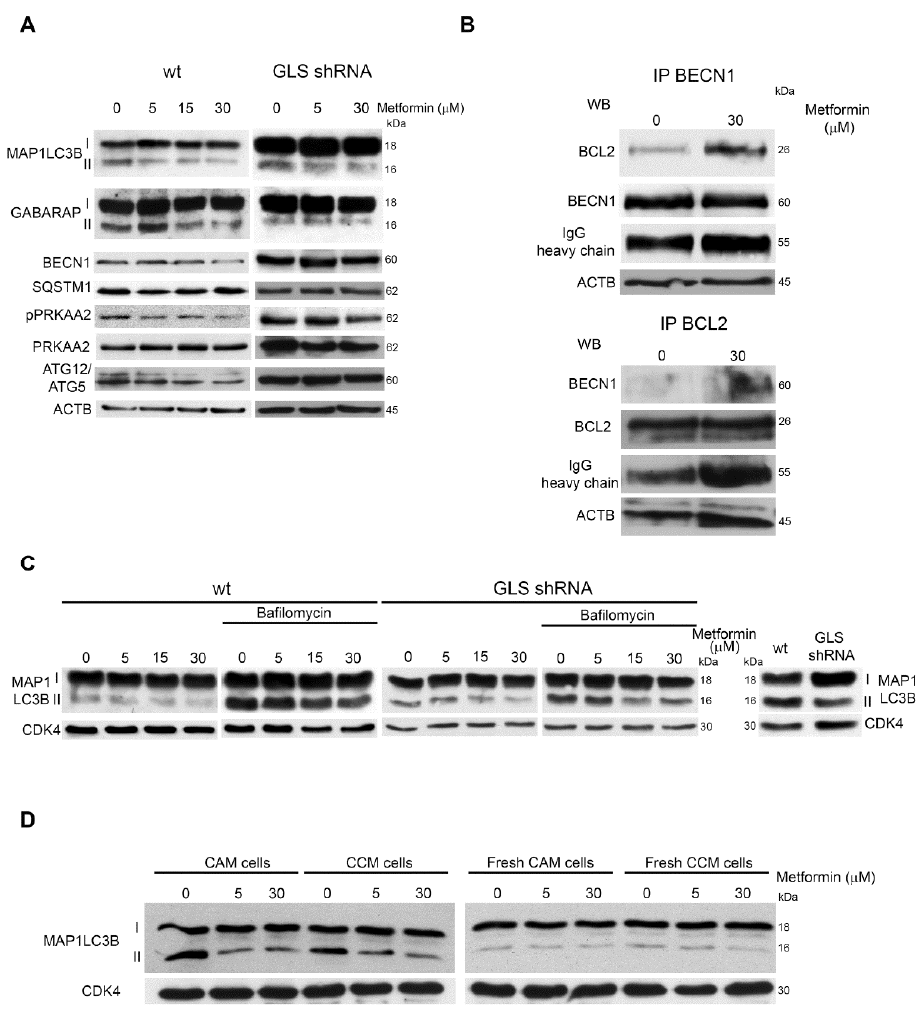
Figure 4. Metformin alters autophagy response; ( A )MDA-MB-231 and MDA-MB-231 GLS shRNA cells were either left untreated or treated with Metformin for 20 days. At the end of the